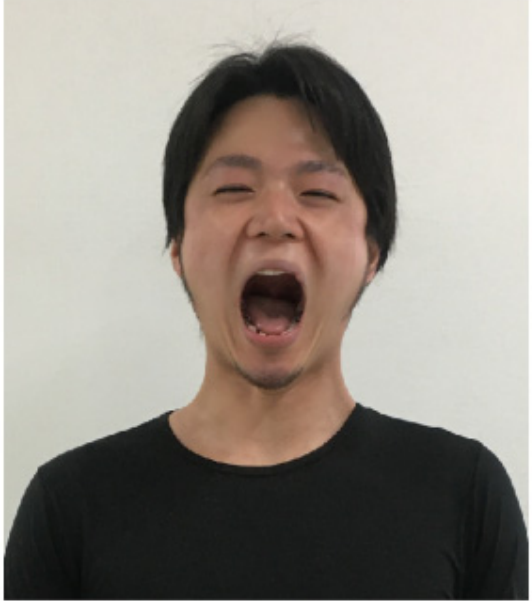
Figure 3. Jaw-opening exercise. The subjects opened their jaws to the maximum